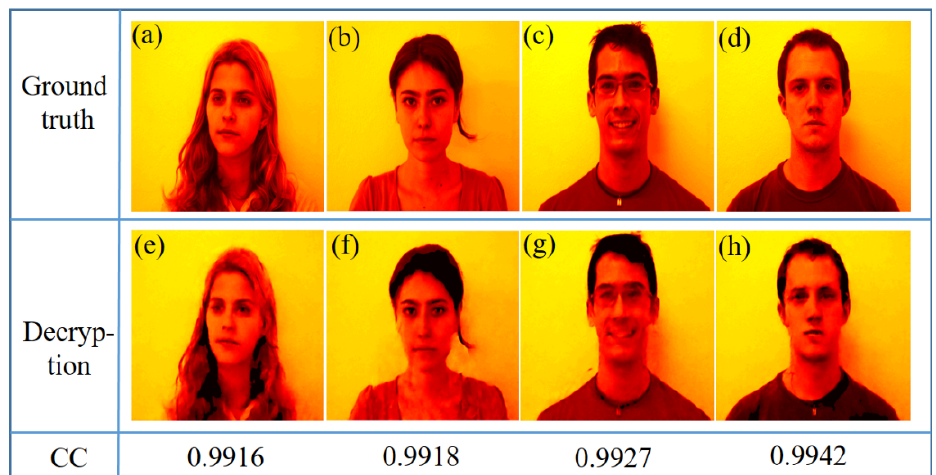
Figure 9. FEI face decryption results. ( a – d ) Groudtruth; ( e – h ) Decryption.